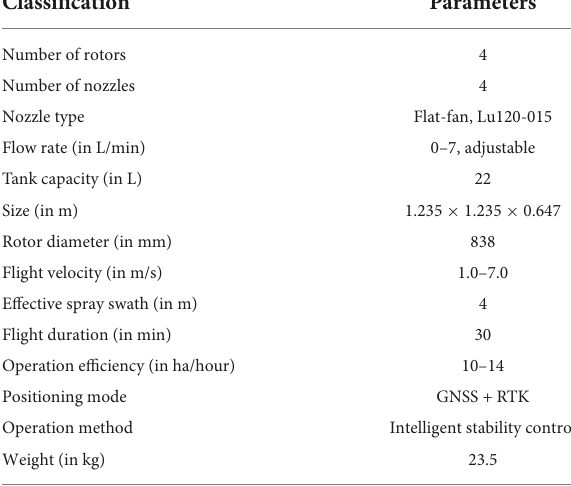
TABLE 1 Technical parameters of the plant protection UAV used in this study.